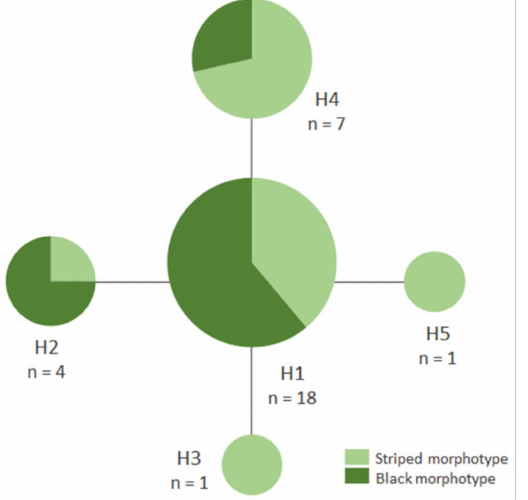
Figure 3. Median-joining network of DNA barcode haplotypes of Argopistes sexvittatus (Chrysomeli- dae: Alticini) ( n =